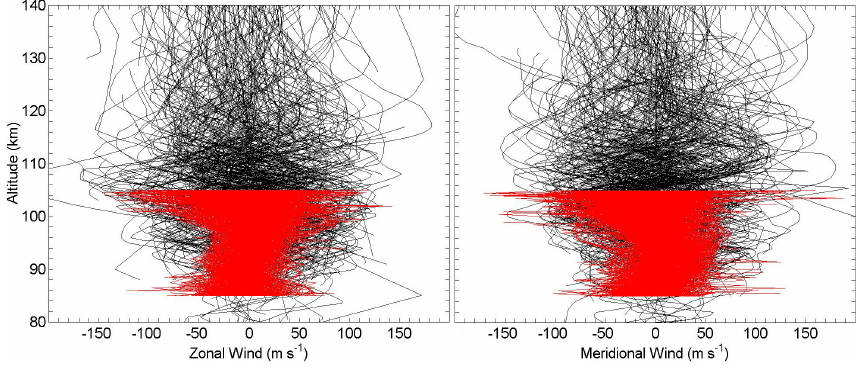
Fig. 2. Superposition of zonal and meridional wind profiles obtained with the Doppler sodium lidar over a seven-year period (red curves) and the wind components obtained from the chemical release wind measurements (black curves).